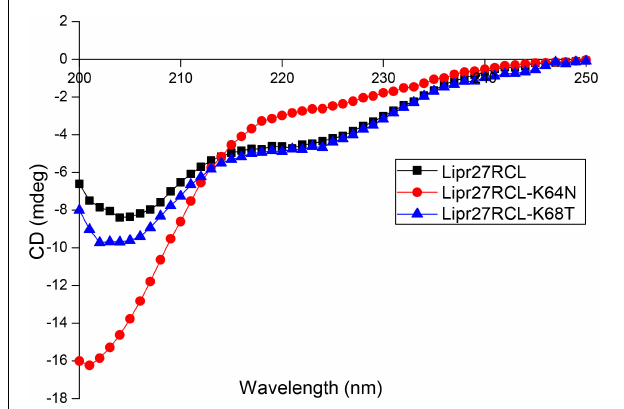
FIGURE 5 | Circular dichroism spectra (CD) of Lipr27RCL, Lipr27RCL-K64N, and Lipr27RCL-K68T.